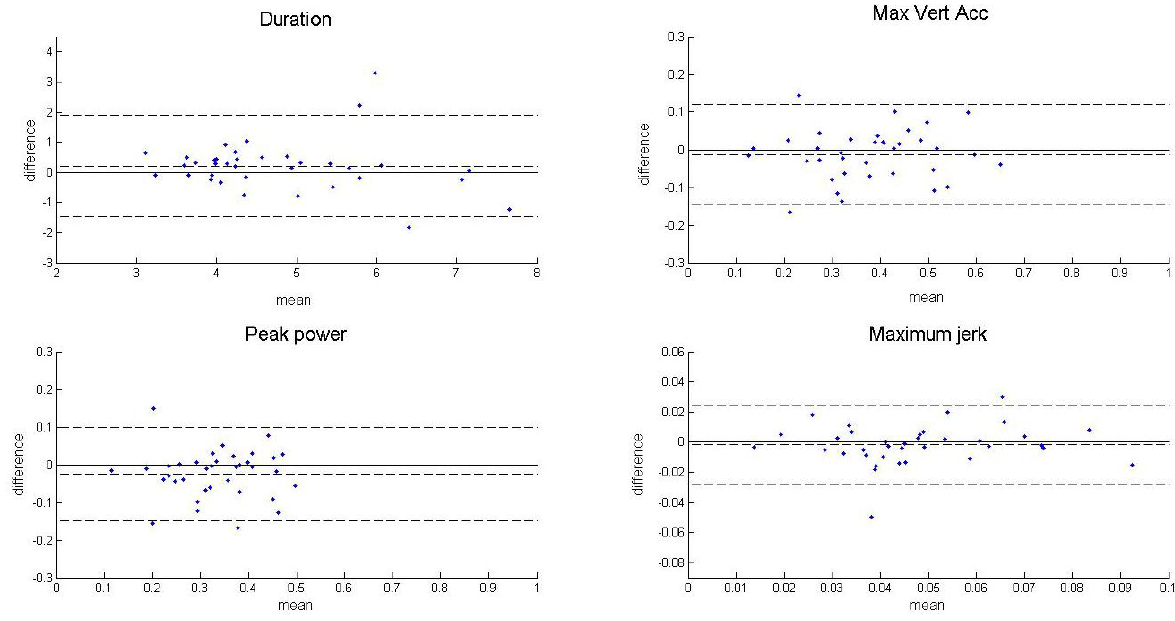
Figure 2. Bland-Altman plots of average measurements over all tests. The mean of differences between the test and the test scores is indicated by the dotted line in the middle of the plot. The upper and the lower boundaries of the 95% CI are indicated by the dotted lines above and below the mean. All measurement scores are dimensionless numbers.